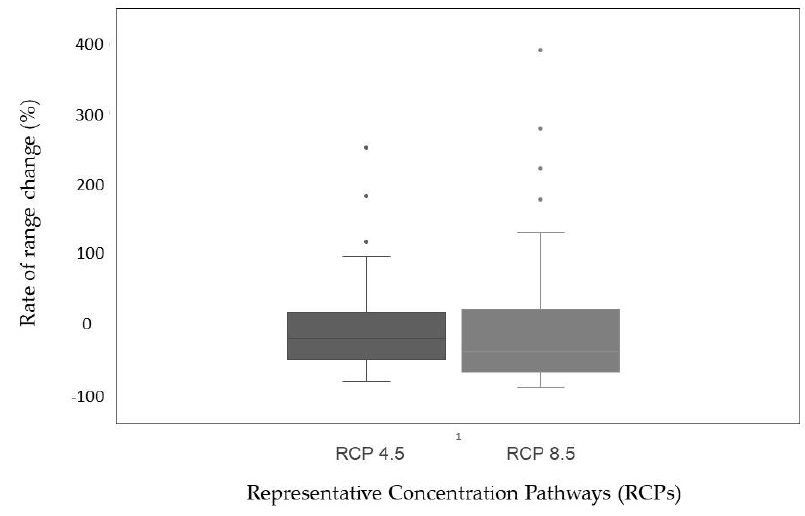
Figure 4. Differences in rate of range change (%) between the two Representative Concentration Pathways (RCPs), dots represent those species that will increase their area more than the